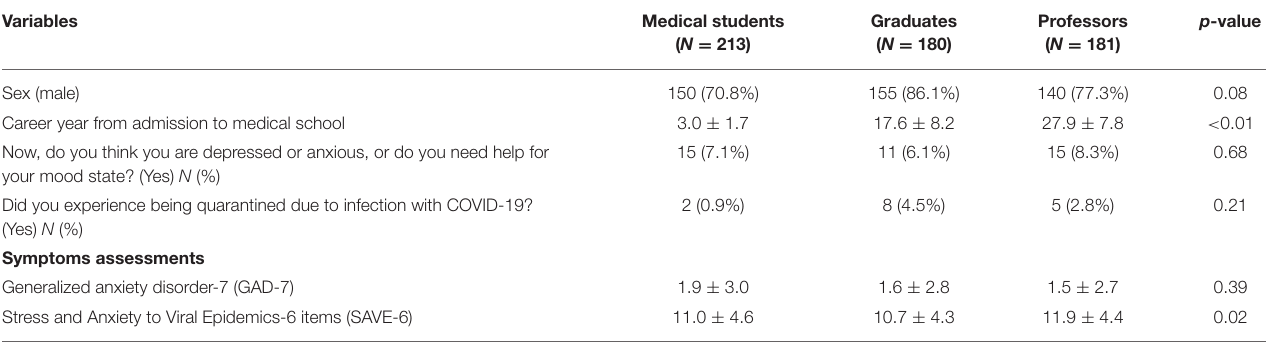
TABLE 1 | Demographic characteristics of subjects ( N =